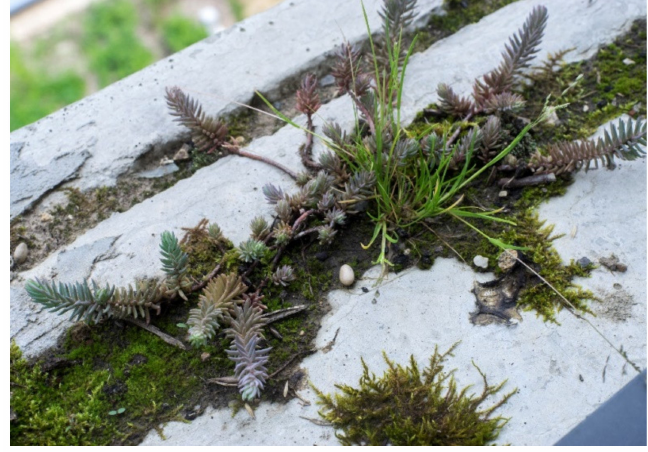
Figure 15. Biodiversity at the walls of Ecole des Sciences et de la Biodiversit é (© Myr